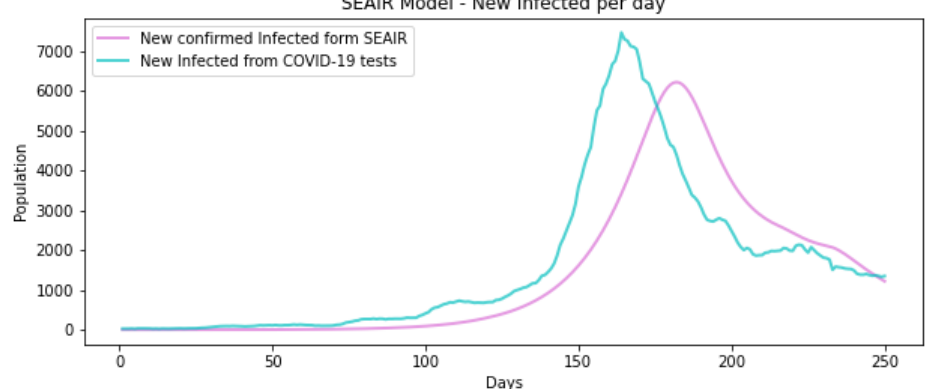
Figure 6. Comparison of cumulative infected people between SEAIR model and COVID-19 tests in Austria’s second wave after applying the best vaccination plan found.